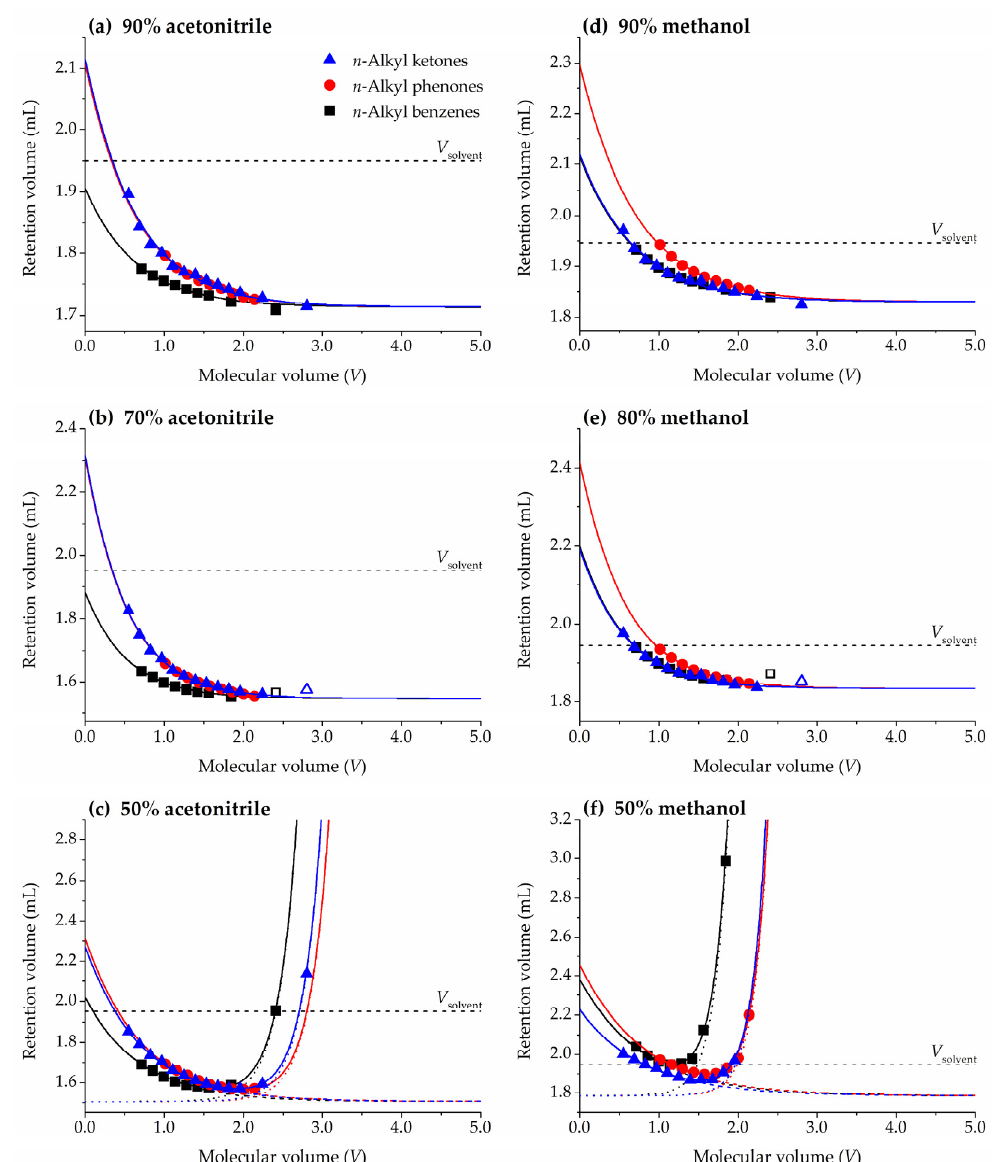
Figure 1. Representative plots of pure HILIC (( a ) 90% acetonitrile, ( d ) 90% methanol), HILIC and slightly RPLC (( b ) 70% acetonitrile, ( e ) 80% methanol), and mixed HILIC-RPLC (( c ) 50% acetonitrile, ( f ) 50% methanol) behavior in the ZIC-HILIC column. For ( a , b , d , e ) solid lines represent fittings to Equation (6) (empty symbols in ( b , e ) represent homologues not included in the fittings). For ( c , f ) solid lines represent fittings to Supplementary Materials: Equation (S1), dashed and dotted lines show the contributions to the mixed mode of HILIC and RPLC, respectively. The dashed straight line shows the solvent volume inside the column pycnometrically measured ( V solvent ).